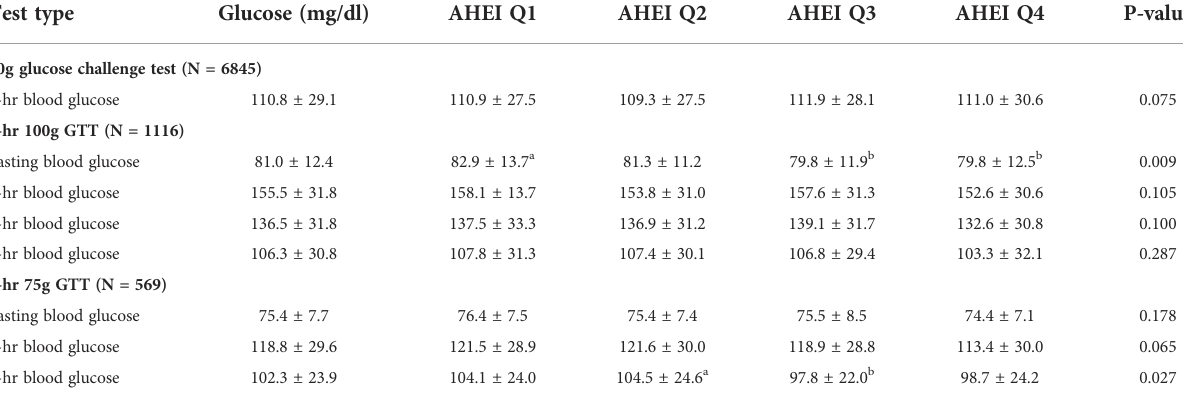
TABLE 2 Blood glucose concentrations from GDM screening and diagnostic tests strati fi ed by AHEI-2010